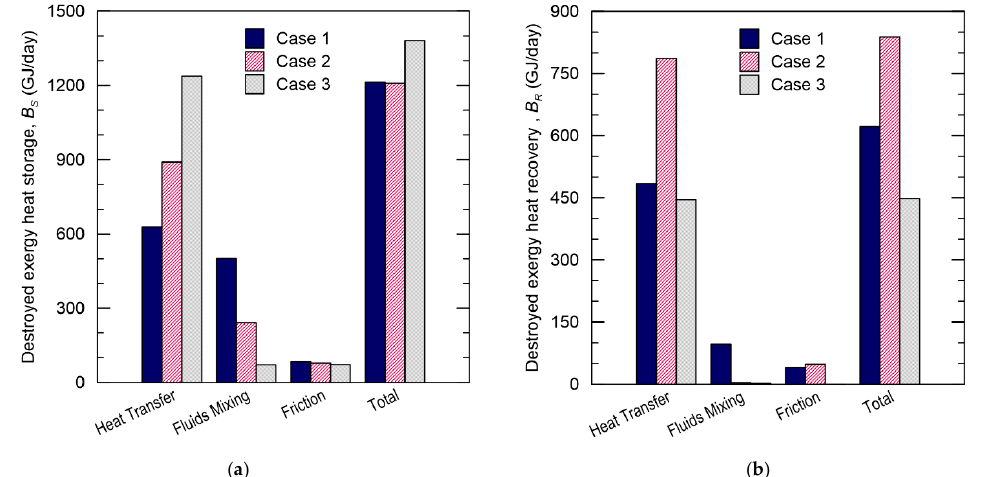
Figure 3. Destroyed exergy specified by the irreversible processes for analyzed cases under: ( a ) heat storage operation, and ( b ) heat recovery operation.